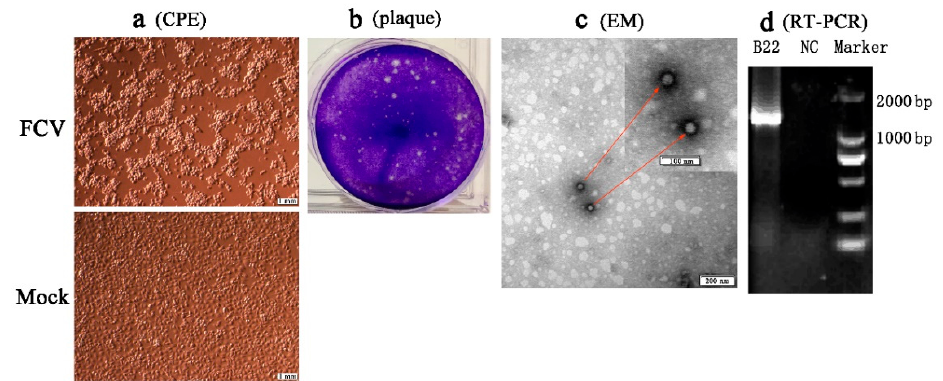
Figure 2. Isolation and identification of an FCV strain (SMU-B22-2020) in this study. ( a ) CRFK cells were inoculated with FCV SMU-B22-2020 and uninfected medium is shown at 12 h postinfection; ( b ) plaque assay for SMU-B22-2020 isolate with a dilution of 10 − 10 of virus stock using CRFK cells; ( c ) FCV particles with a diameter of approximately 30 nm were observed in cell supernatants by transmission electron microscopy (EM). Red arrows indicate the FCV particles; ( d ) the FCV isolate was further confirmed by RT-PCR with a 1300 bp target fragment. NC indicates the negative control.